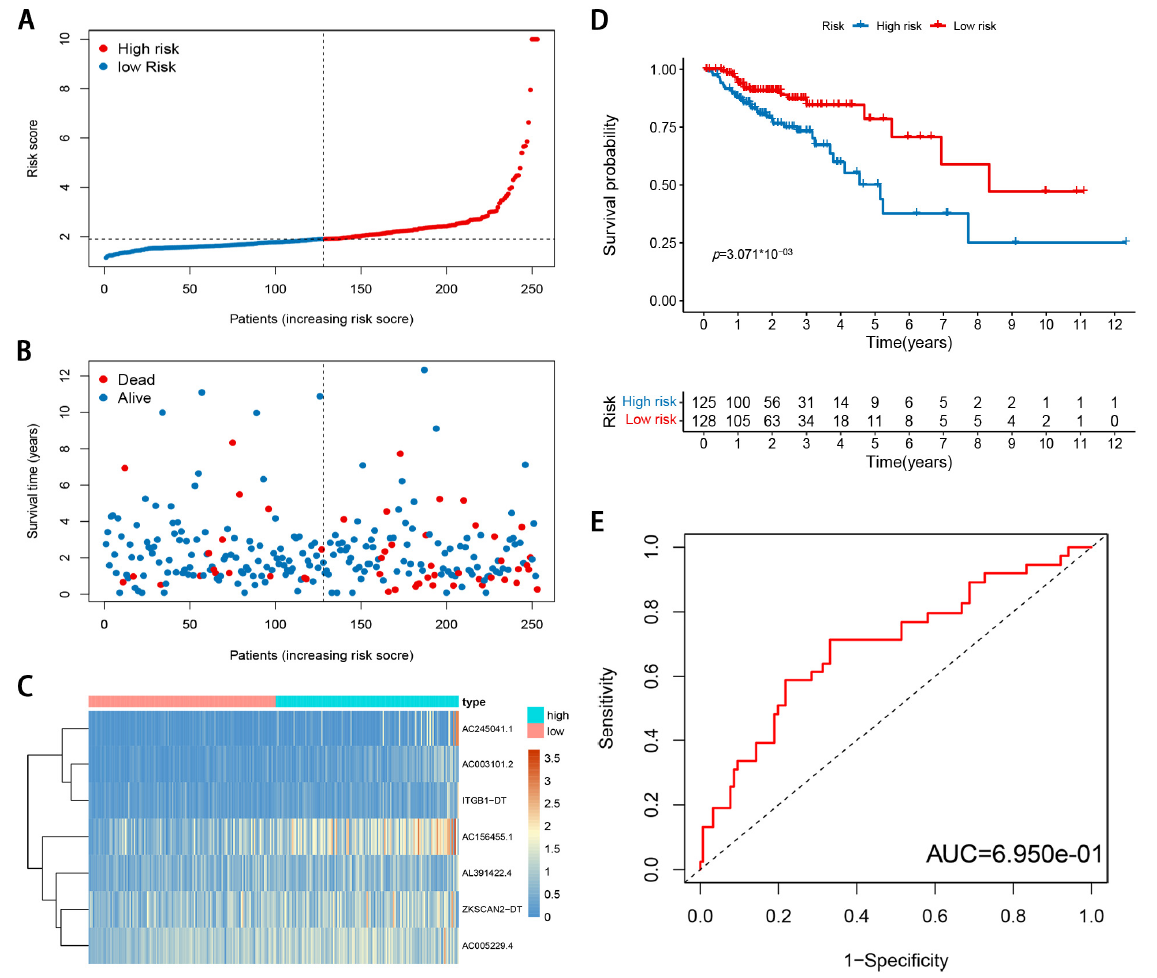
Figure 5. Validation of m6A-modified lncRNA signature in TCGA validation cohort. ( A ) The risk score distribution. Blue dots represent risk score for low-risk patients; red dots represent risk score for high-risk patients. ( B ) The relationship between survival status and risk score. The abscissa represents the number of patients, and the ordinate is the risk score. Red dots represent dead patients, blue dots are living patients. ( C ) Heatmap showing the expression profile of the seven signature lncRNAs. ( D ) Kaplan–Meier method was used to plot the RFS curve for the high-risk score and low-risk score groups. ( E ) ROC curves and AUCs of the 7-gene